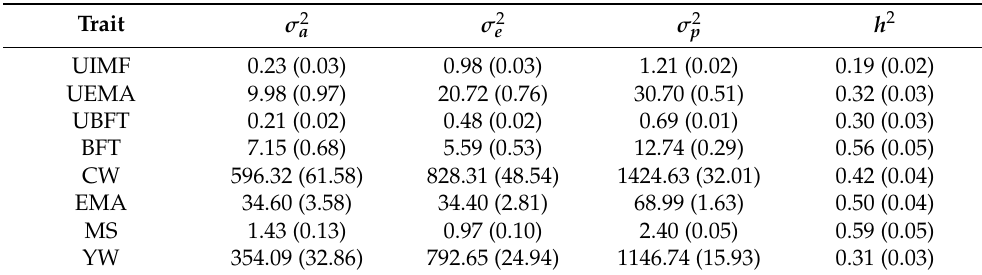
Table 2. Heritability and variance component estimated from pedigree and phenotypic information using the multi-trait model in the Hanwoo cattle.